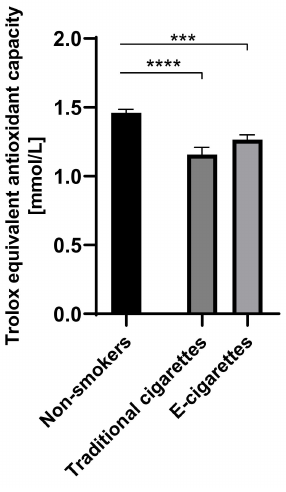
Figure 6. Values of TEAC (Trolox equivalent antioxidant capacity) in groups of e-cigarettes users, traditional cigarettes smokers and non-smokers. *** p < 0.001; **** p < 0.0001. Statistically significant correlations between values of TAOS on level of p < 0.0003 in the group of e-cigarette users and on the level of p < 0.0001 in the group of traditional cigarettes smokers were also observed and are presented in Figures 7–10.